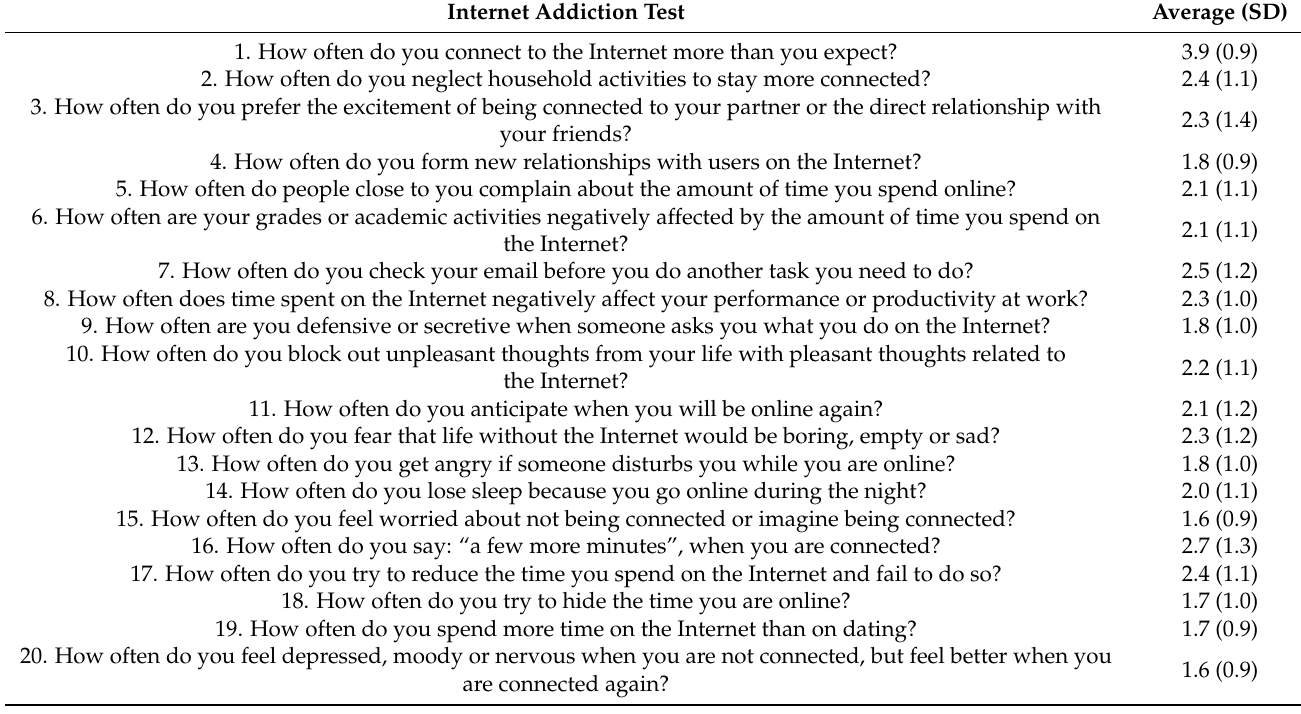
Table 4. Average values obtained in the items of the IAT instrument (n = 192). Internet Addiction